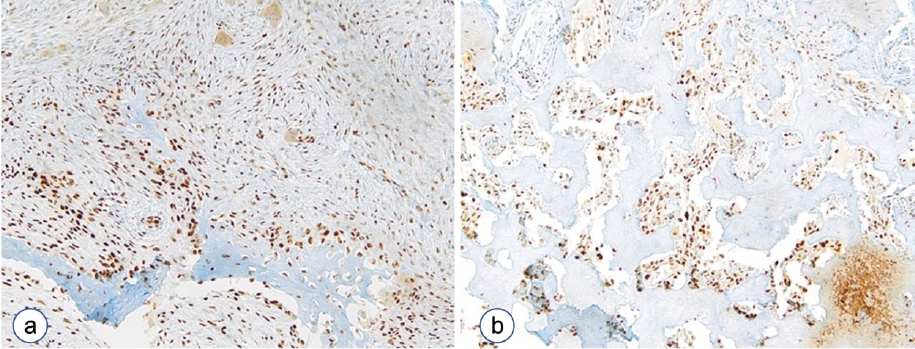
Figure 7. P ‐ Runx2 staining in FD of the jaw. P ‐ Runx2 over ‐ expression in representative cases of FD. Figure 7. P-Runx2 staining in FD of the jaw. P-Runx2 over-expression in representative cases of FD. ( a ) Thin trabeculae type. ( b ) Pagetoid type. Magnifications, ×4 (b), ×10 (a). ( a ) Thin trabeculae type. ( b ) Pagetoid type. Magnifications, × 4 ( b ), × 10 ( a